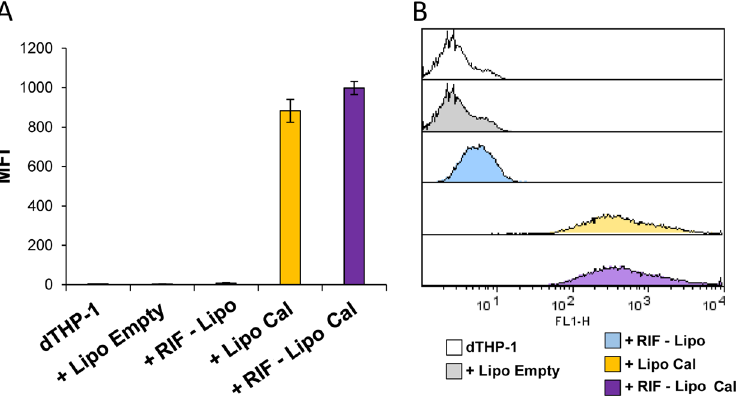
Figure 6. Liposome internalization analysis within macrophages. dTHP-1 (5 × 10 5 cells/mL) were stimulated for 18 h with empty liposomes (Lipo Empty) or with RIF-loaded liposomes (RIF–Lipo), containing or not calcein (Cal). Cells were collected and liposome uptake was analyzed by flow cytometry. Results are shown as mean ± SD of mean fluorescence intensity (MFI) values obtained from three independent experiments ( A ) of which representative flow cytometry histograms are reported ( B ).